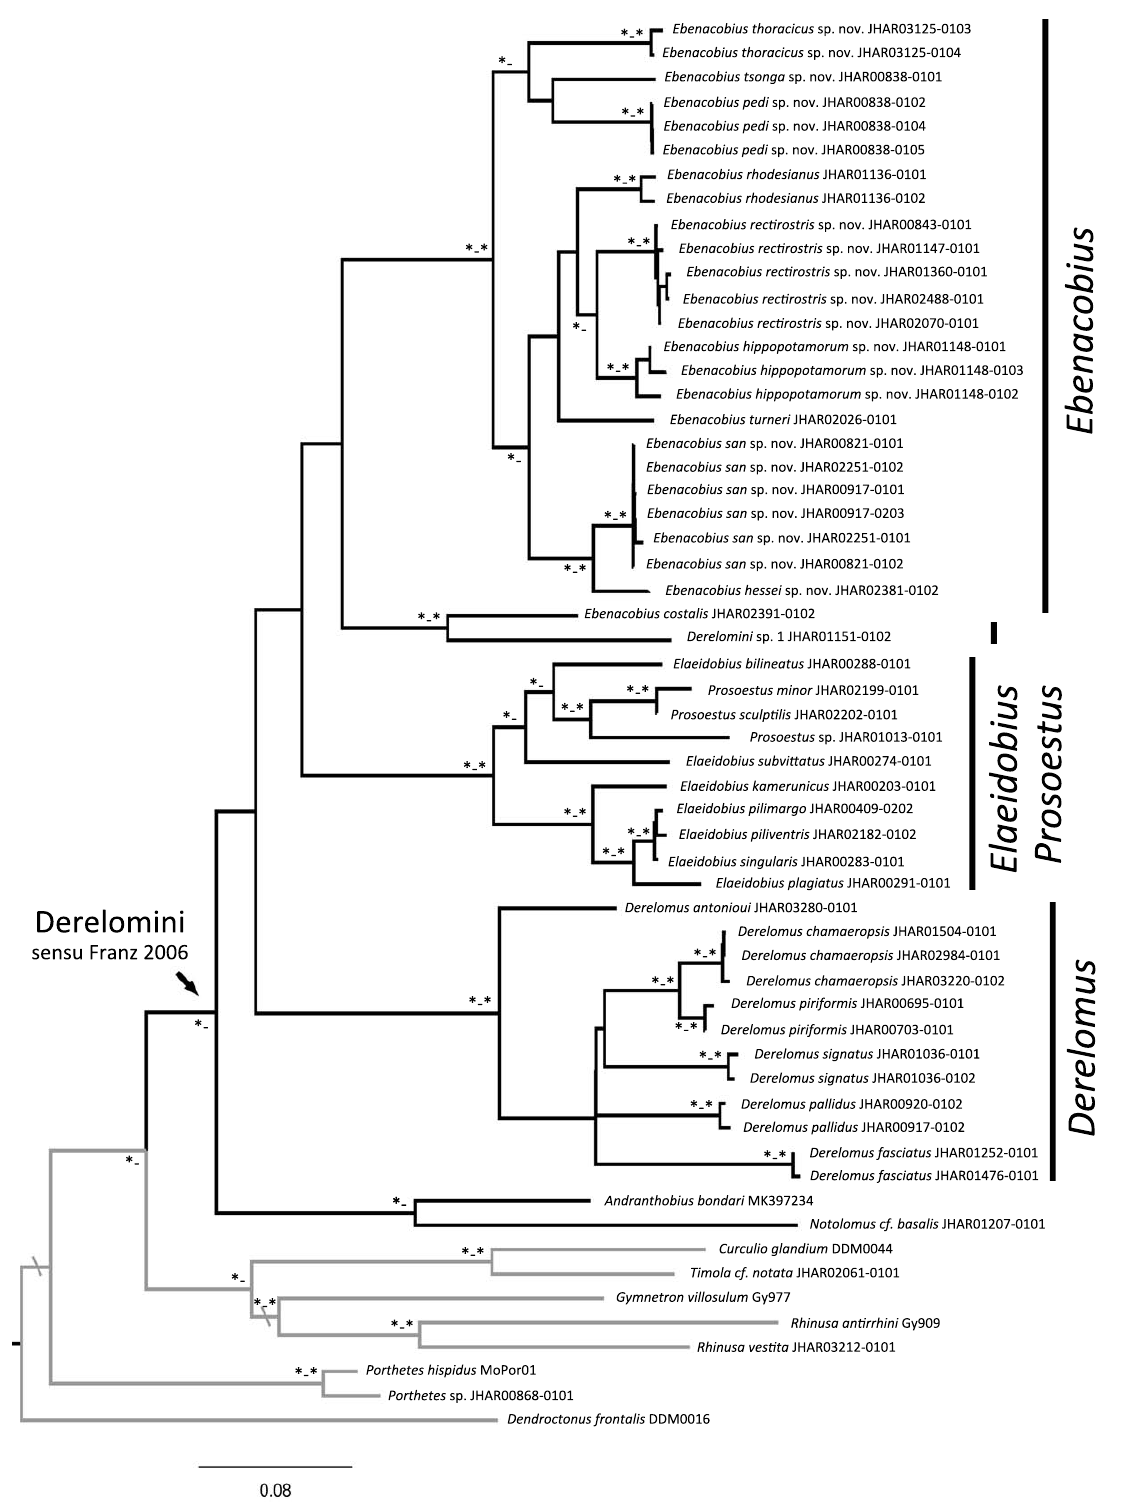
Fig. 8. Best-fit ML tree of Ebenacobius Haran gen. nov. and Afrotropical Derelomini resulting from the partitioned analyses of the concatenated molecular dataset (the scale bar represents the estimated number of nucleotide substitutions per site). Support values (*) at nodes indicate SH-aLRT ≥ 80% and uBV ≥ 95% values, in that